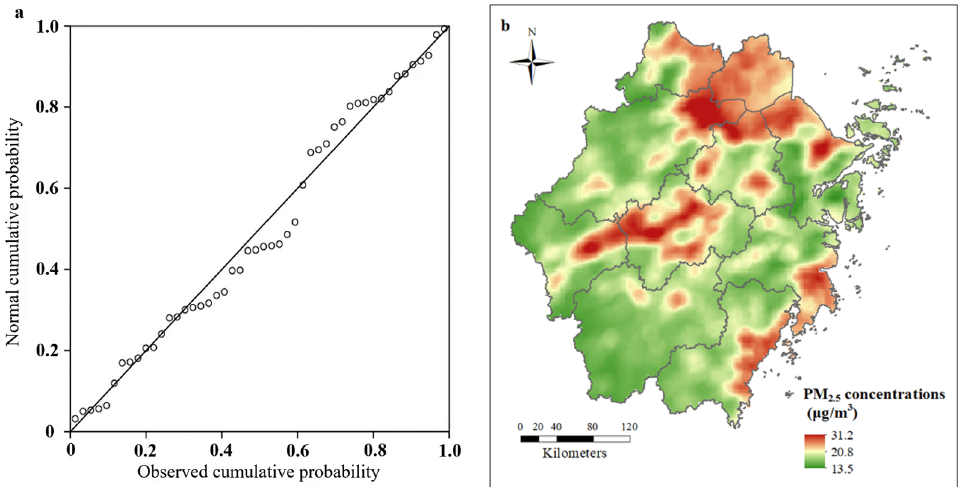
Figure 3. ( a ) Standardized residual probability–probability (P-P) plot. ( b ) Multiple linear regression simulation results.